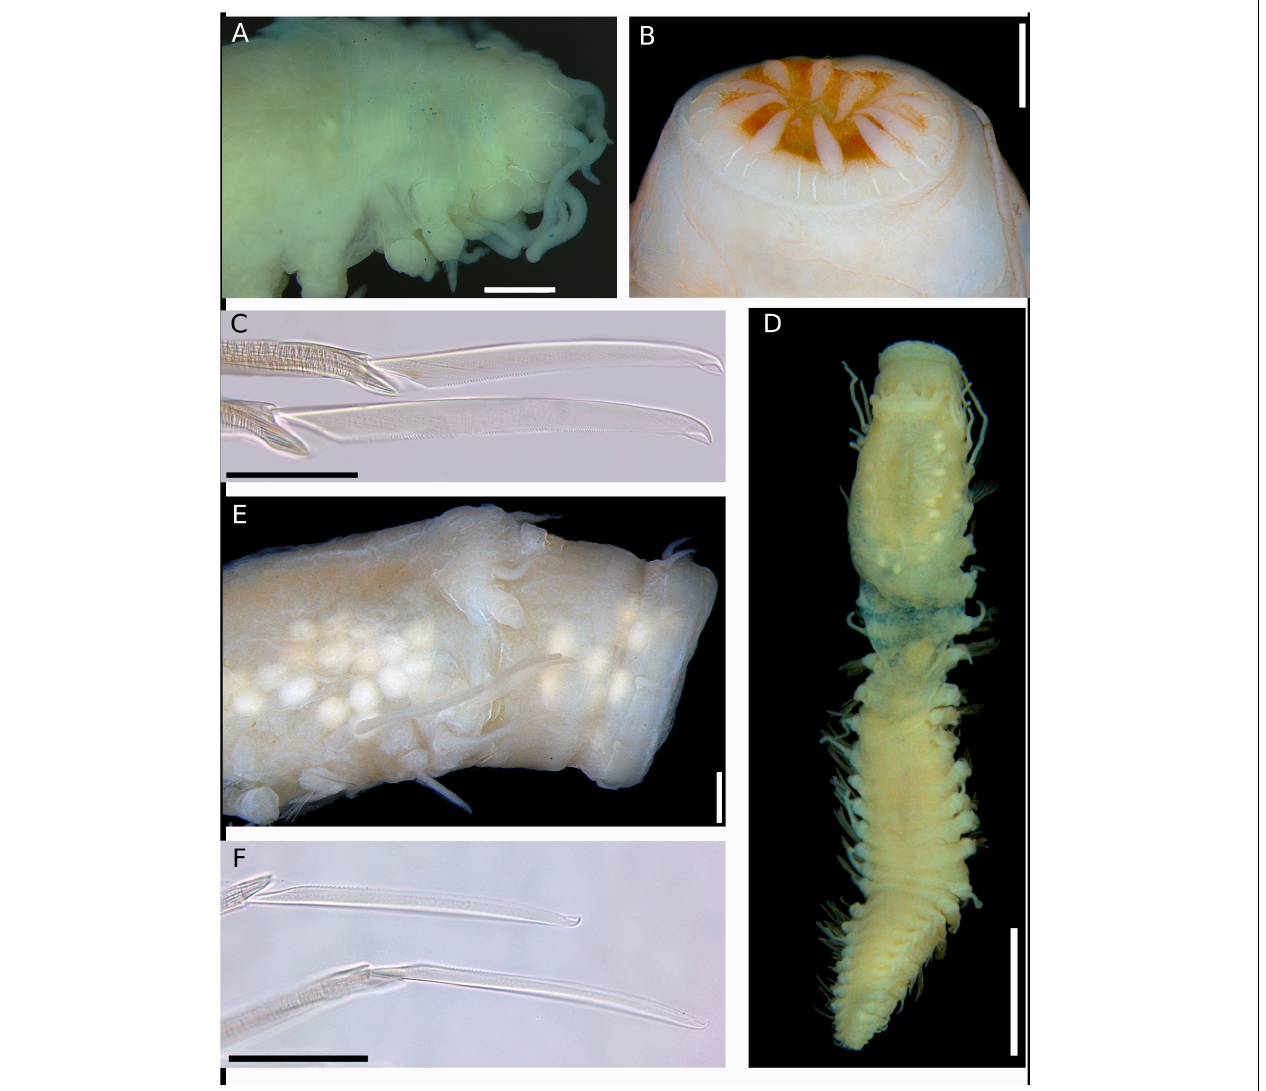
FIGURE 12 | (A–C) Sirsoe alphadelphini sp. nov. (A) anterior end, dorsal view; (B) detail of proboscis; (C) neurochaetae. (D–F) Sirsoe ungava sp. nov. (D) complete specimen, dorsal view; (E) anterior end, lateral view; (F) neurochaetae. Scales: (A,B) 500 µ m; (C) 50 µ m; (D) 2 mm; (E) 250 µ m; (F) 30 µ m.